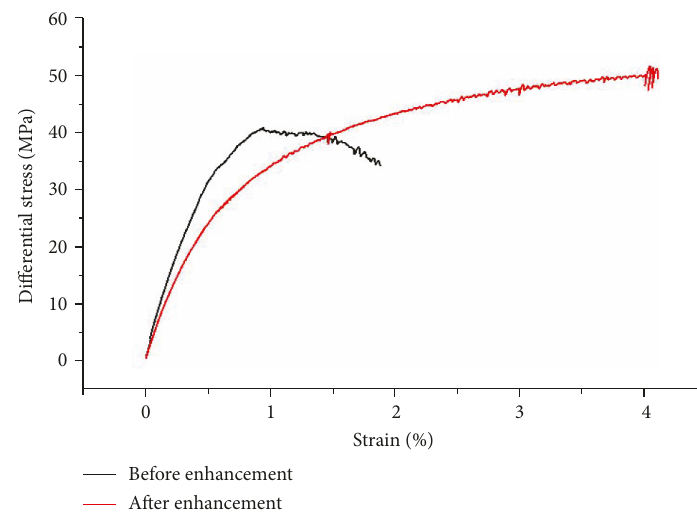
Figure 8: Stress-strain curves of cement stone.